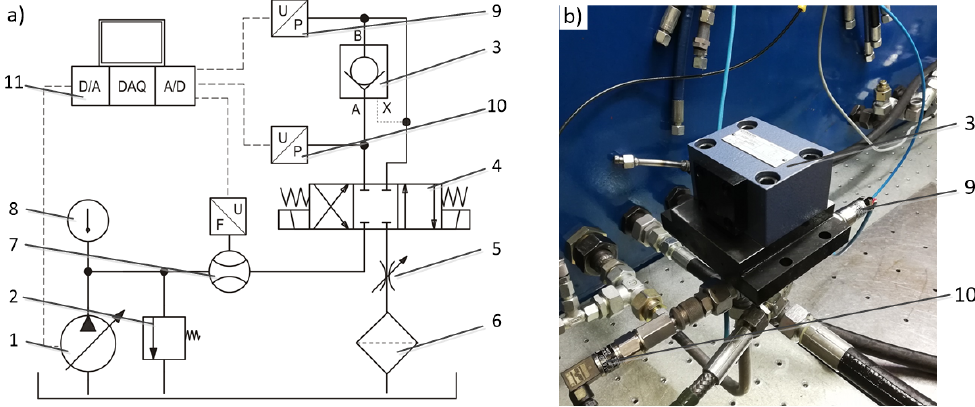
Figure 20. Test bench: ( a ) scheme, ( b ) valve; 1—pump, 2—relief valve, 3—tested check valve, 4—control valve, 5—throttle valve, 6—filter, 7—flow meter, 8—temperature gauge, 9,10—pressure transducers, 11—computer DAQ system.